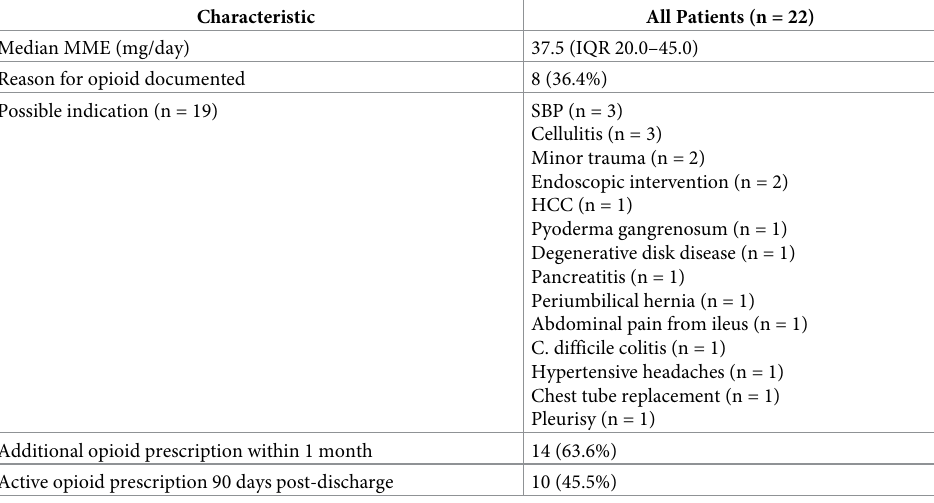
Table 7. Outpatient opioid prescriptions among previously opioid-na ï ve patients.